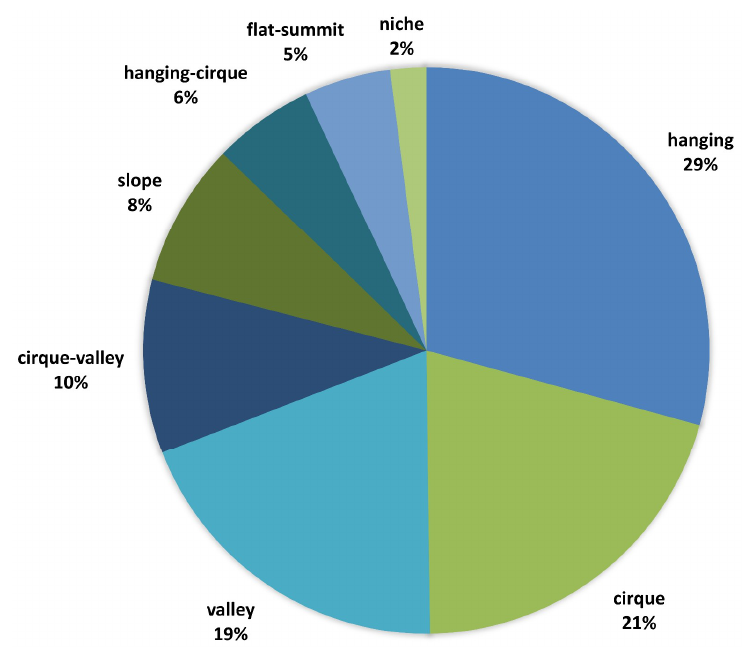
Figure 10. Distribution of the number of glaciers at the peak of the LIA by morphological types.